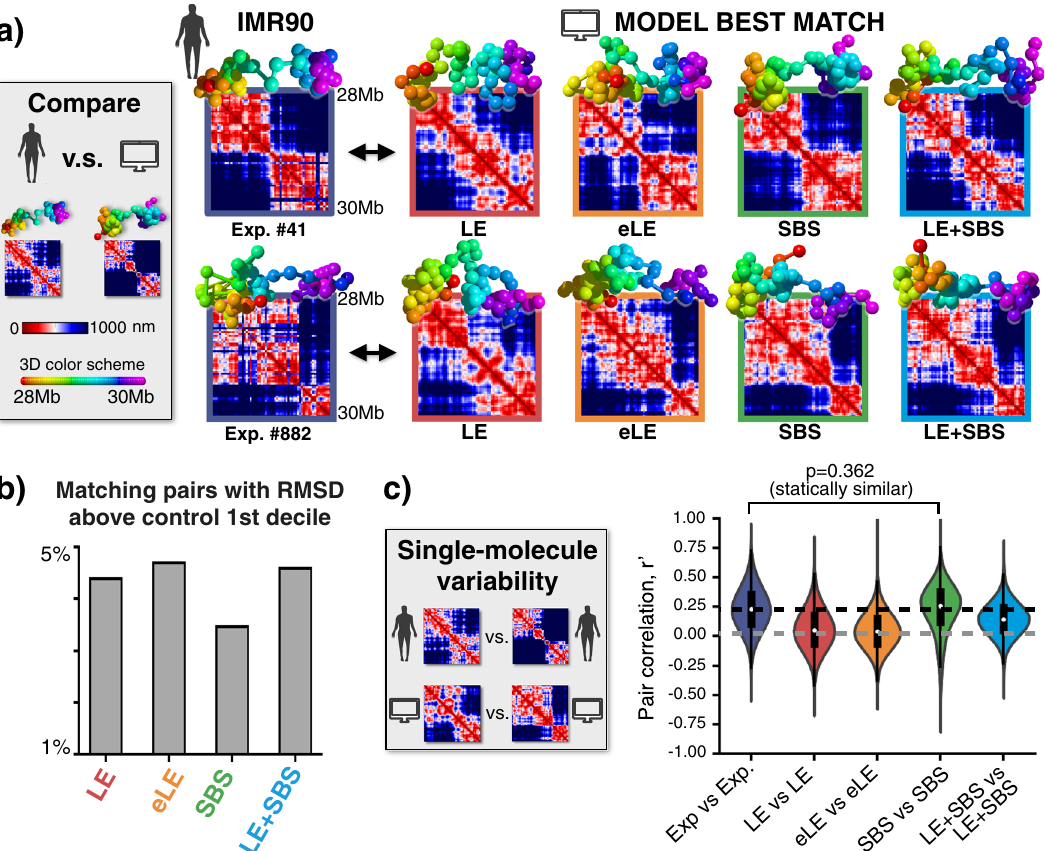
Fig. 3 Single-cell chromatin conformations are well captured by the model 3D structures, especially by phase-separation based ones. a Microscopy single-cell chromatin structures of the IMR90 locus 6 (left) are associated to their best matching single-molecule conformation in each model via the minimum RMSD criterion. Here two examples of best match are shown for each model type. b Less than 5% of the best-matching experiment-model pairs have an RMSD above the 1st decile of the control distribution. c The variability of microscopy single-molecule structures is measured by the distribution of r ' correlations between pairs of distance matrices and is compared to the variability of in-silico structures. The r ' distribution of the SBS model is statistically indistinguishable from the experimental one (two-sided Mann – Whitney test p -value = 0.362). The boxplots represent the median, interquartile ranges, whiskers within 1.5 times the interquartile range. n = 1000 independent single-molecule conformations for each model. Source data are provided as a Source Data fi